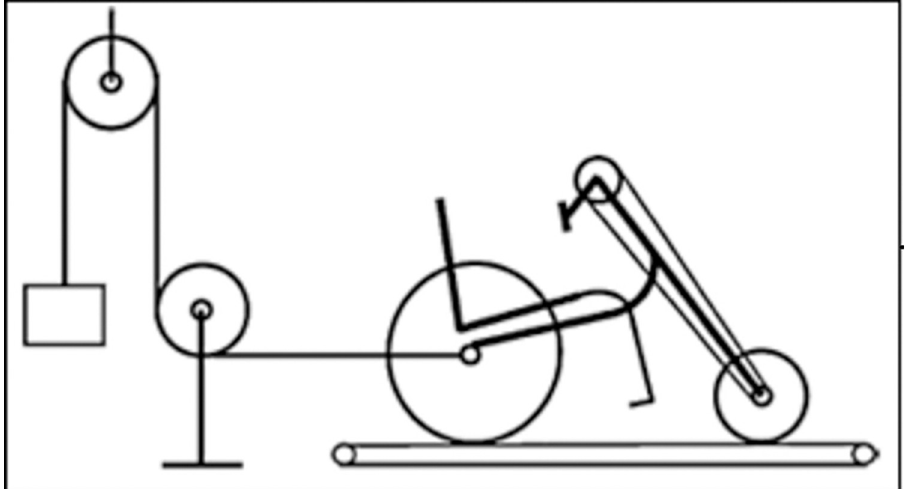
Fig 1. Pulley system attached to the handcycle on the